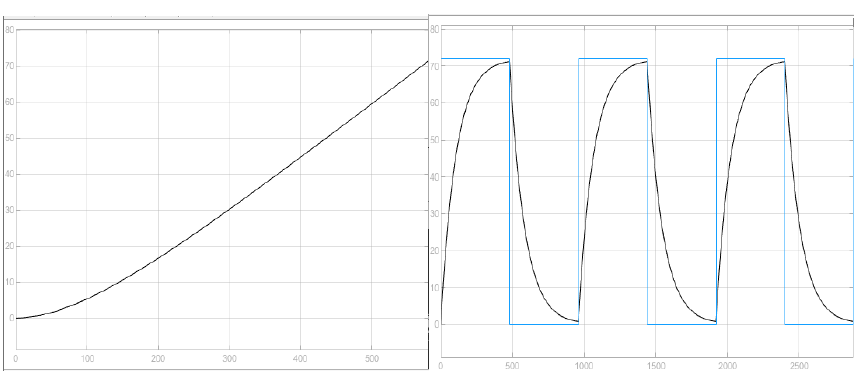
Figure 8. Response of the knitting process to a ramp and pulse generator input per cycle, n = 1.